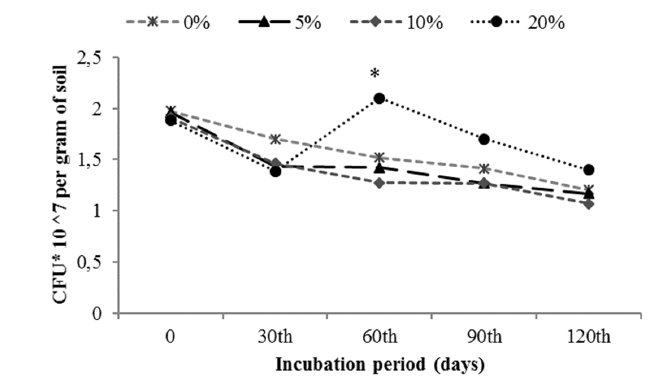
Figure 4. Growth response of Psuedomonas mendocina S10 in soil treated with moisture percentages 0%, 2.5%, 5%, and 10% Each data point represents no. of bacterial colonies per gram of soil. One-way ANOVA determined the significance of difference. Each data point represents mean and the vertical line on it indicates the standard error. The asterisk shows significance level: p<0.05 with 0-day